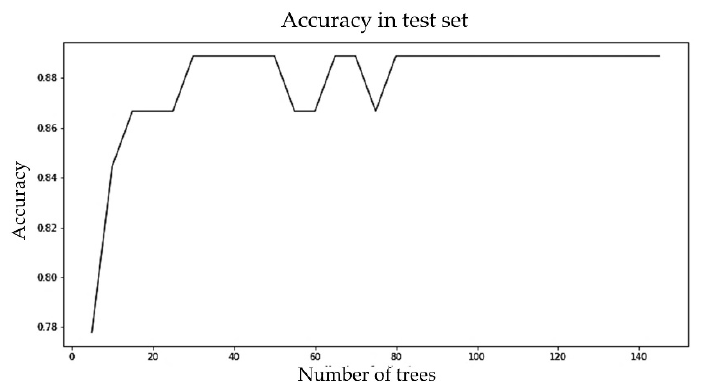
Figure 14. Accuracy vs. number of estimators (trees) for the random forest model for the multiple random well-child visit scenario.